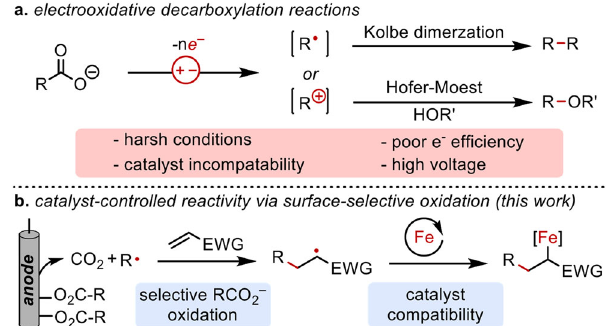
Fig. 1 Electrochemical Decarboxylation in Synthesis. a Common electrooxidative decarboxylation reactions. b Selective oxidation of carboxylates enabled by dielectric formation on an anodic